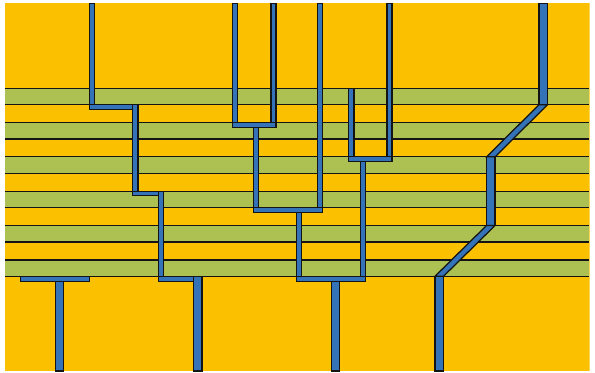
Figure 24: Schematic of types of observed fracture behavior crossing interfaces [40].